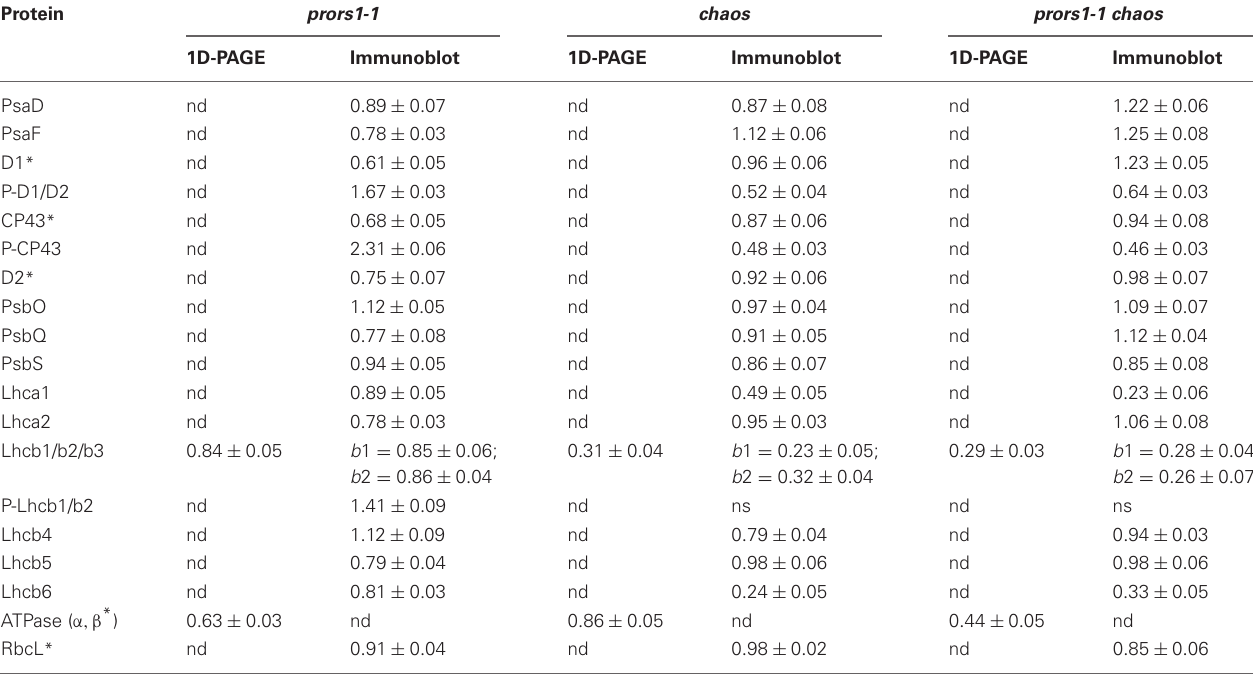
Table 3 | Quantification of thylakoid (phospho)proteins in light-adapted mutant ( prors1-1 , chaos, and prors1-1 chaos ) and WT (Col-0) plants.